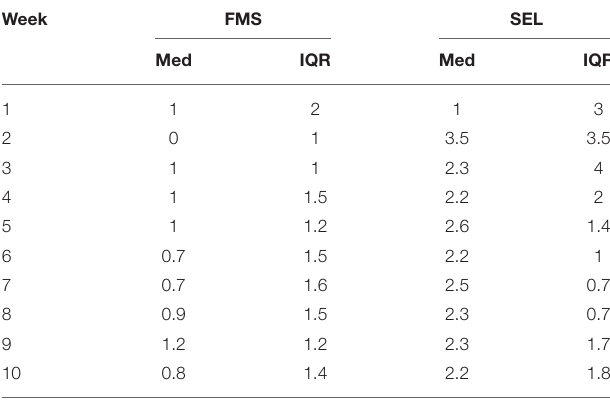
TABLE 3 | Enjoyment of each session as rated by the children and parents. Session no.